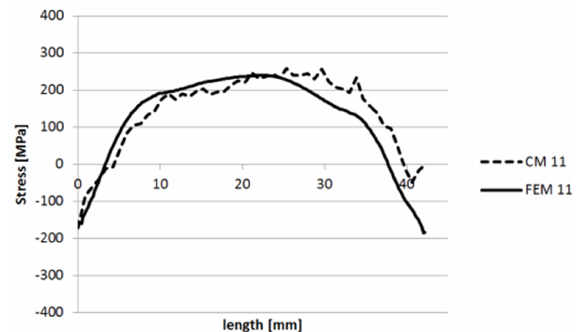
Figure 40. Stress levels in 11 direction along the CD line segment.